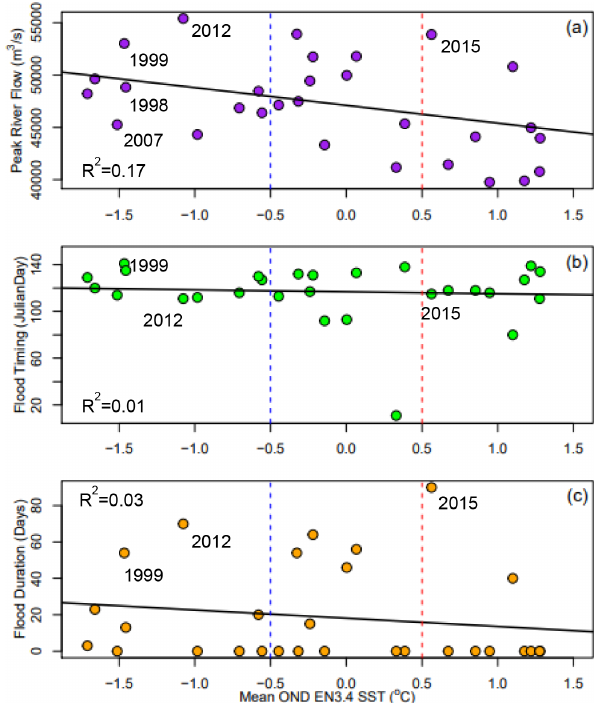
Figure 11. Scatterplot of the mean OND SST anomaly in the EN3.4 region vs. (a) the annual river flow magnitude, (b) peak flow timing and (c) flood duration (i.e. days over the 95th percentile of flow) for the Tamshiyacu (2) gauging station for the period 1986–2015. Straight black lines represent the regression line, with the R 2 value provided for each. Major flood events are highlighted by the respec- tive